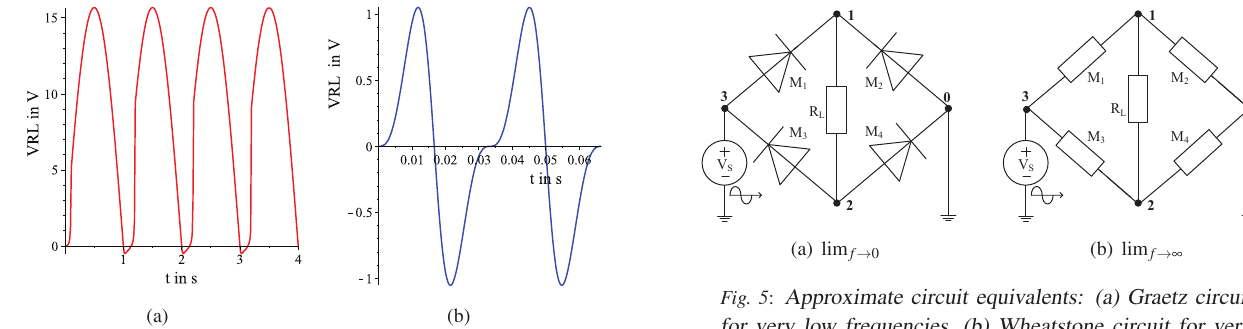
Fig. 3 : Voltage V RL as a function of time t, sine AC voltage source, V 0 = 30 V , x n ( t = 0 ) = 0 . 5 , (a) f = 0 . 5 Hz , (b) f = 30 Hz .